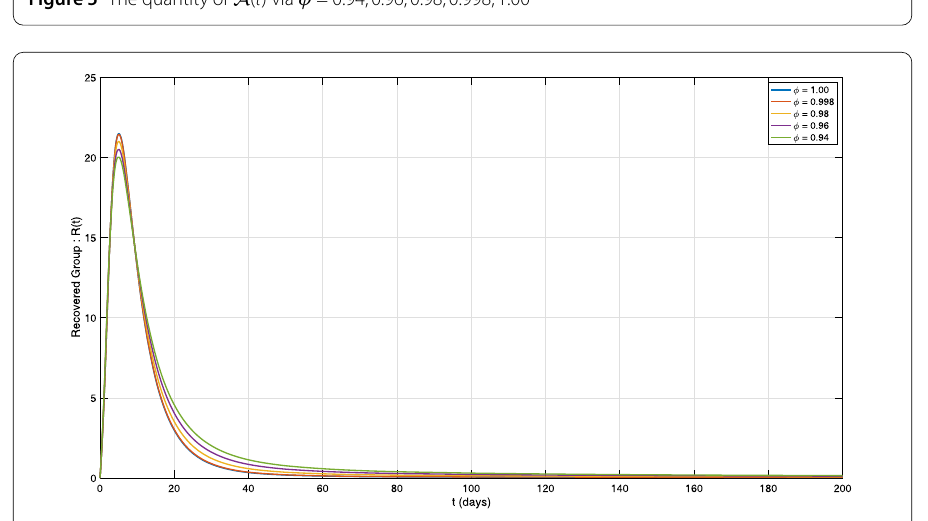
Figure 5 The quantity of A ( t ) via φ = 0.94,0.96,0.98,0.998,1.00